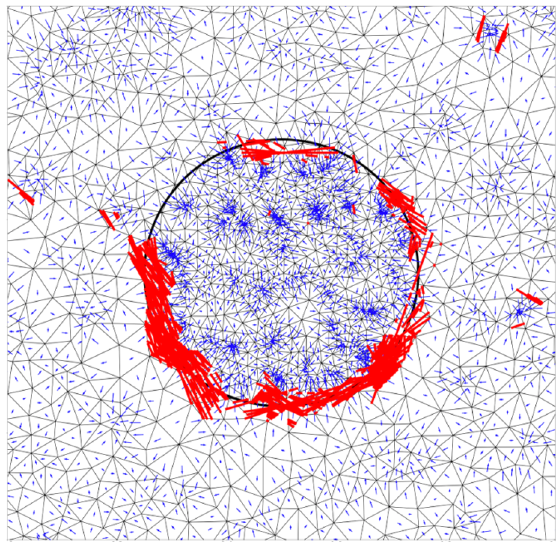
Figure 27 . The individual segment selection procedure described in section 7.2.2. After scanning the ( p in , p out ) parameter space on an 80 × 80 grid and computing the wombling measures ¯ Γ[ C ] , the average flux for each individual line segment ∆ ‘ α has been rescaled according to (7.3) with γ = 4 and the plot shows (in red) the segments with rescaled flux values in the top 1